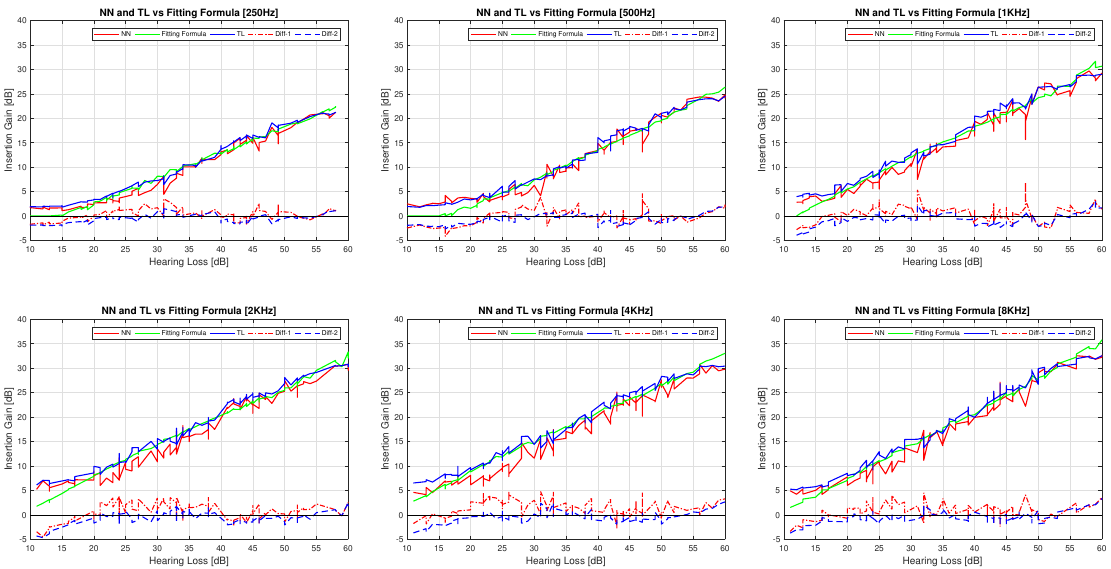
Figure 10. NAL-NL2: Performance comparison for NN and TL vs. fitting formula for the 50 dB input level. Comparisons are made for 250 Hz, 500 Hz, 1 KHz, 2 KHz, 4 KHz, and 8 KHz frequencies from top left to right to bottom left to right.